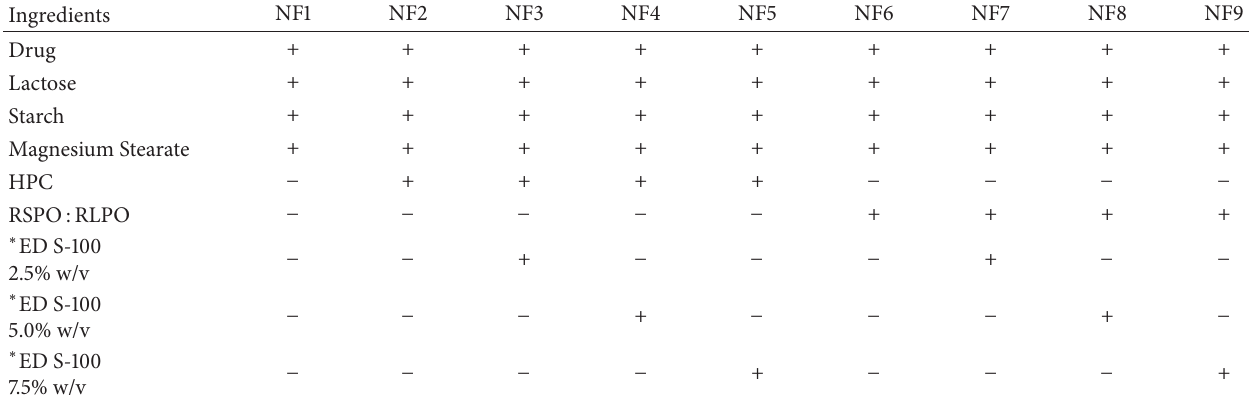
Table 1: Composition of naproxen sodium core, press-coated tablets, and enteric-coated tablets. Ingredients NF1